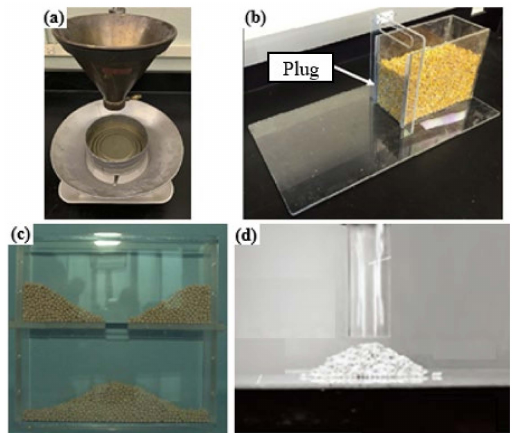
Figure 2. Angle of repose